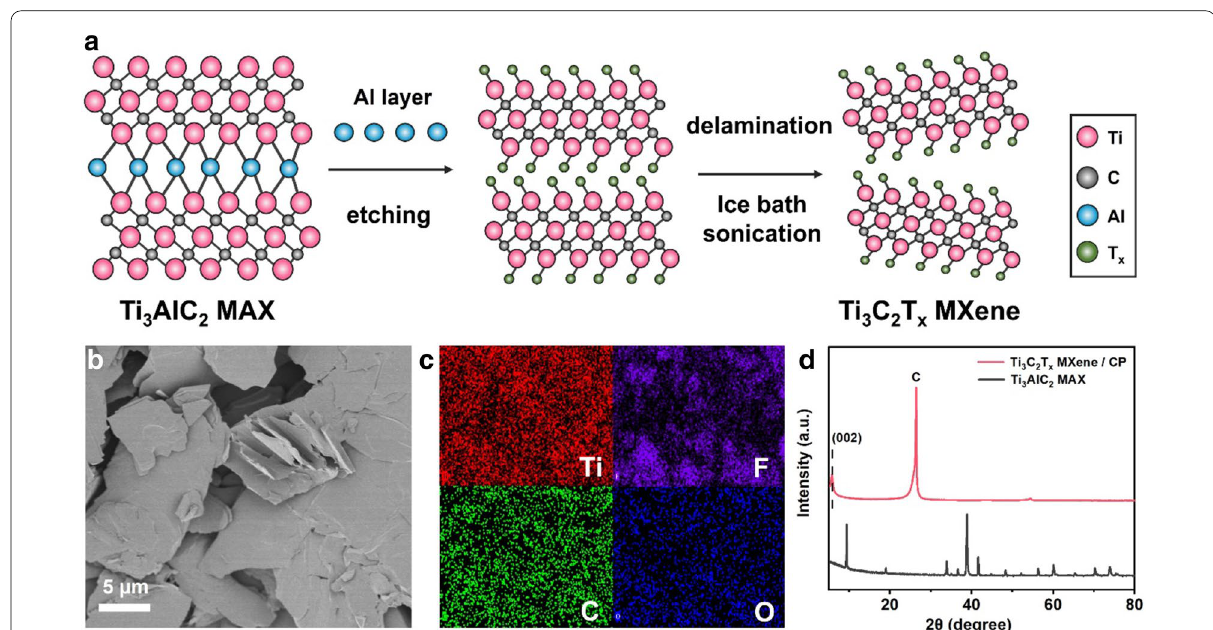
Fig. 1 a Schematic of the synthesis procedure of the Ti 3 C 2 T x MXene. b SEM images of Ti 3 C 2 T x MXene. c EDX elemental mapping profiles of Ti 3 C 2 T x MXene with Ti (red), F (purple), C (green), and O (blue) distributions. d XRD spectra of Ti 3 C 2 T x MXene loaded on carbon paper